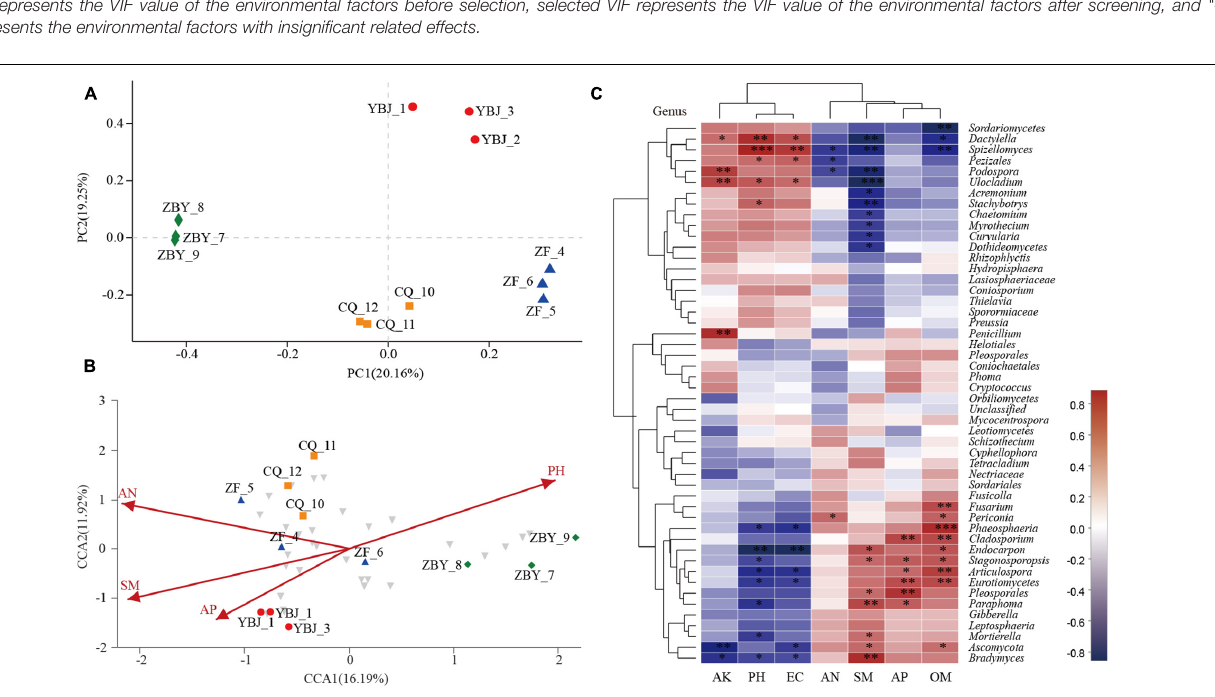
FIGURE 5 | Principal coordinate analysis and Canonical correspondence analysis and correlation heatmap map at the genus level. (A) Principal coordinate analysis (PCoA). (B) Canonical correspondence analysis (CCA). (C) Heatmap diagram of the correlation between soil physical and chemical factors and root-soil flora based on the genus level. R values are shown in different colors in the figure. P -values less than 0.05 are marked with ∗ ( ∗ 0.01 < P ≤ 0.05, ∗∗ 0.001 < P ≤ 0.01, ∗∗∗ P ≤